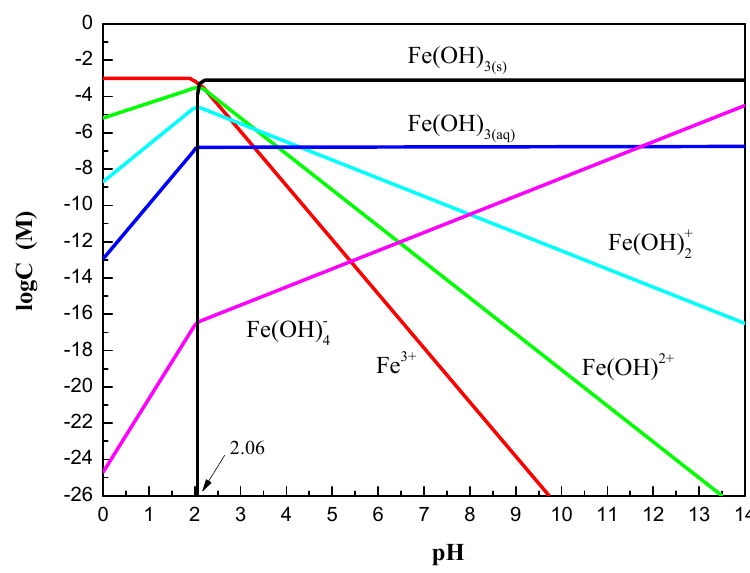
3+ as a function of pH (C